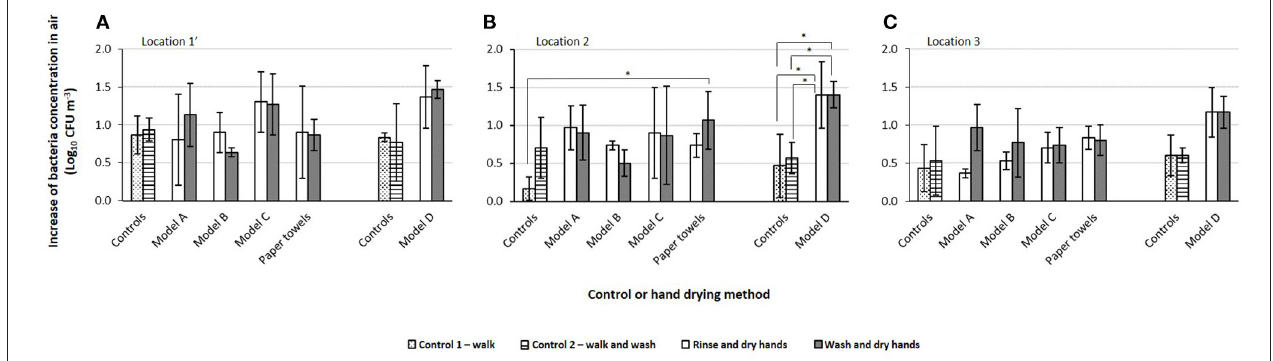
FIGURE 4 | Increases in bacteria concentrations at each sampling location: (A) 1’, side of the dryer, (B) 2, near the dryer, and (C) 3, opposite the dryer, for controls and for each hand drying method. Bars with patterns represent controls experiment 1 and 2: walking only (bars with dots) and walking and washing (bars with stripes); bars with solid fill represent tests, with drying after rinsing hands (white bars) and after washing with soap (gray bars). Asterisks indicate comparisons in which differences are statistically significant ( p < 0.05). Vertical bars represent the standard deviation of